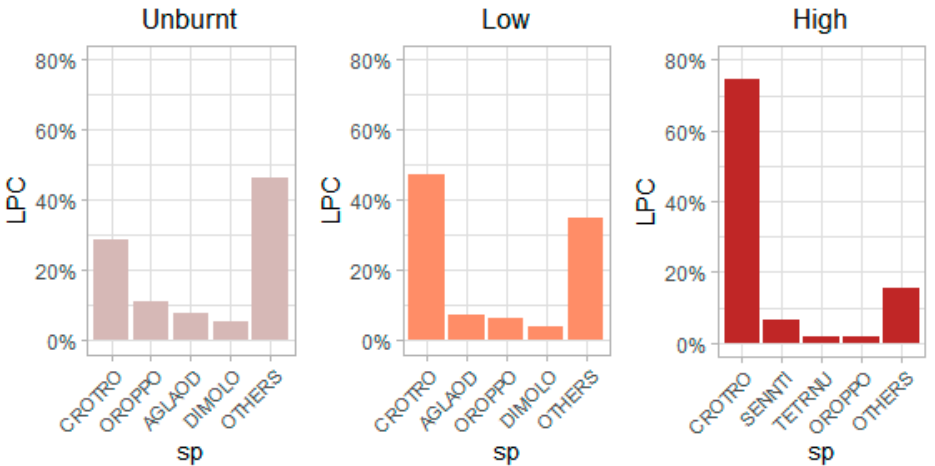
Figure 9. Percent of species-specific contribution of recruits to community-weighted mean trait of leaf phosphorus concentration (LPC) in Huai Kha Khaeng Forest Dynamics Plot, Thailand. Bar charts represent the top four species that their LPC contributed most to the community and all others. Alphabets on the x -axis are the species code (sp) (see Table S1) such as Croton roxburghii ; CROTRO, Orophea polycarpa ; OROPPO, Senna timoriensis ; SENNTI, and OTHERS are other species excluding the top four species. Unburnt, Low, and High are unburnt area, low-intensity burn area, and high-intensity burn area, respectively.